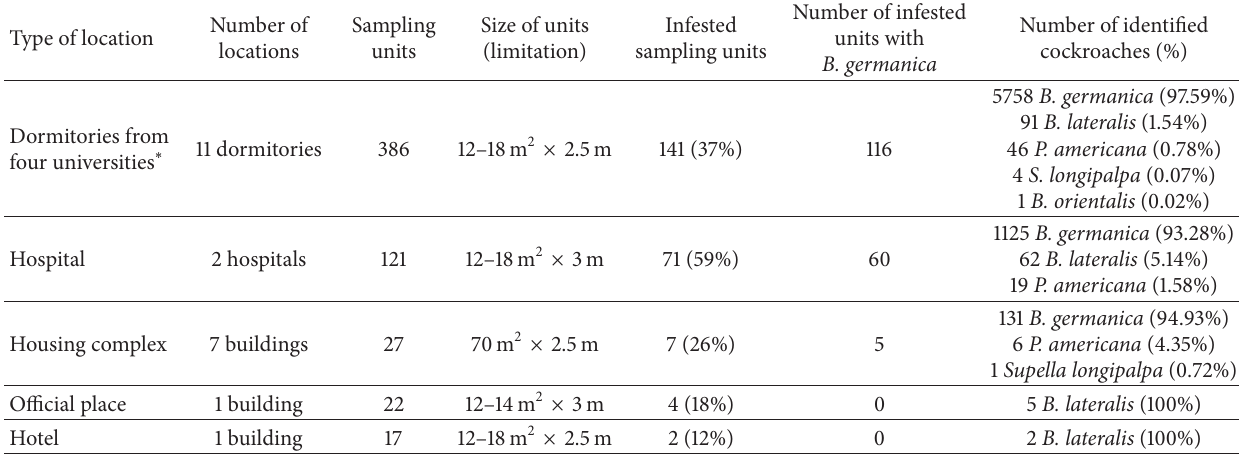
Table 1: Surveyed locations and results of trap monitoring throughout the